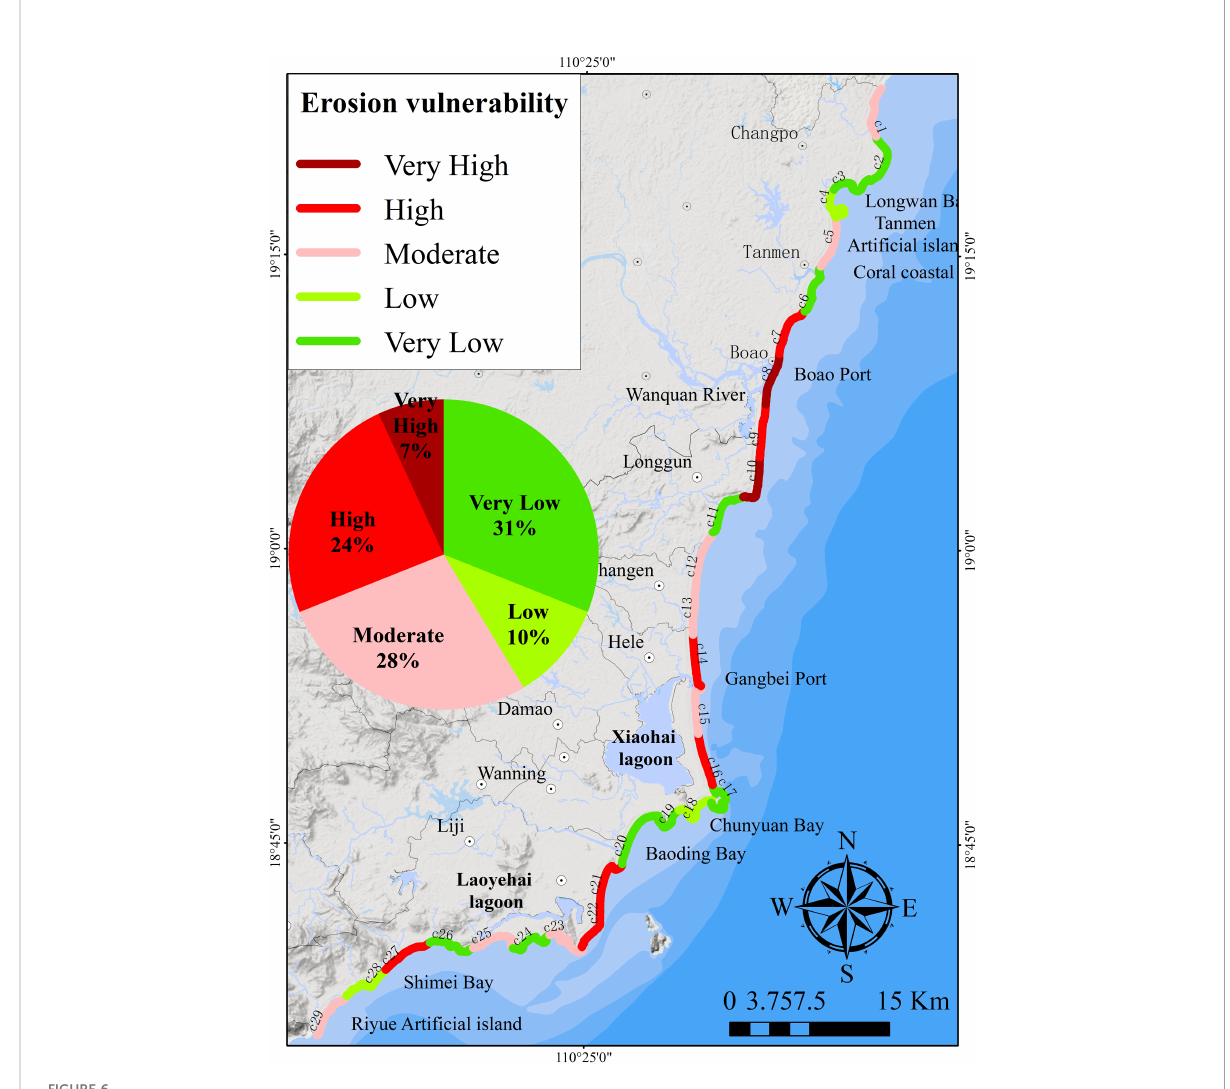
FIGURE 6 Spatial distribution characteristics and proportion of coastal erosion vulnerability in